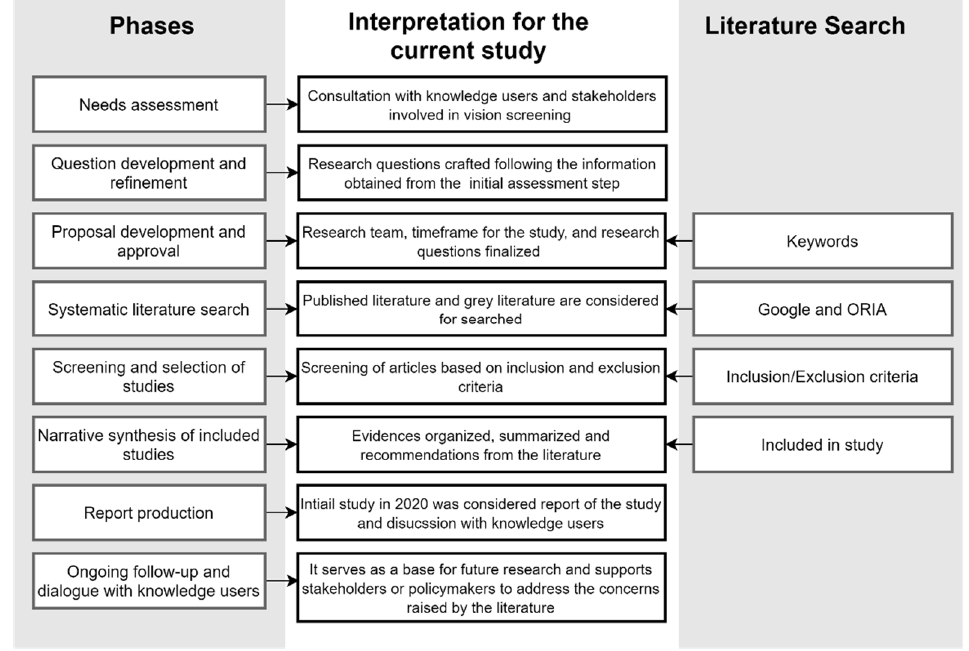
Figure 1. Eight steps iteratively considered for rapid review and their relationship within the context of current study and literature search. current study and literature Table 2. Keywords guided the search of the literature for each research question.